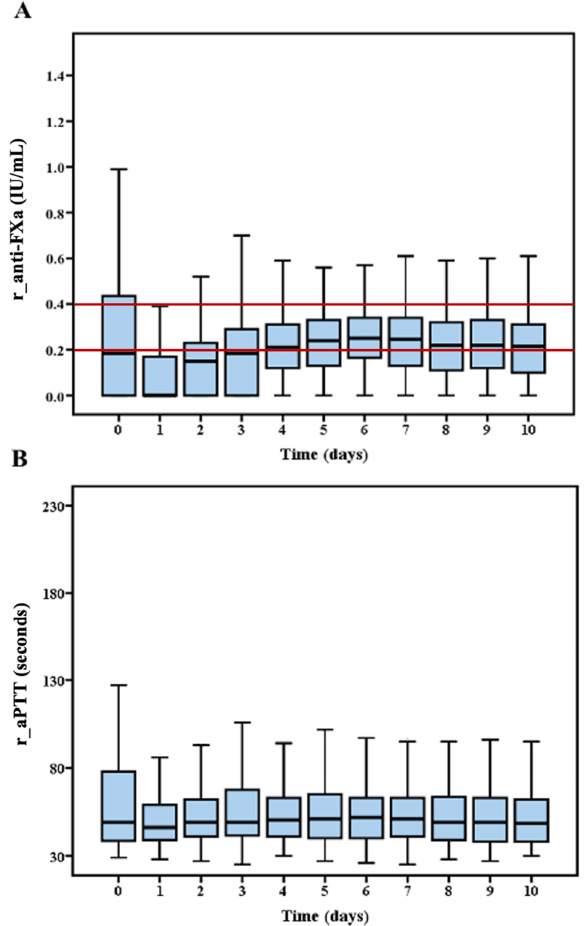
Figure 1. Time courses of reference anti-FXa and aPTT. Tuckey diagrams showing the daily values of reference anti-FXa ( A ) and reference aPTT ( B ) used for the association analysis. Anti-FXa was the reference test for anticoagulation monitoring and the red lines ( A ) describe the targeted anti- FXa interval.